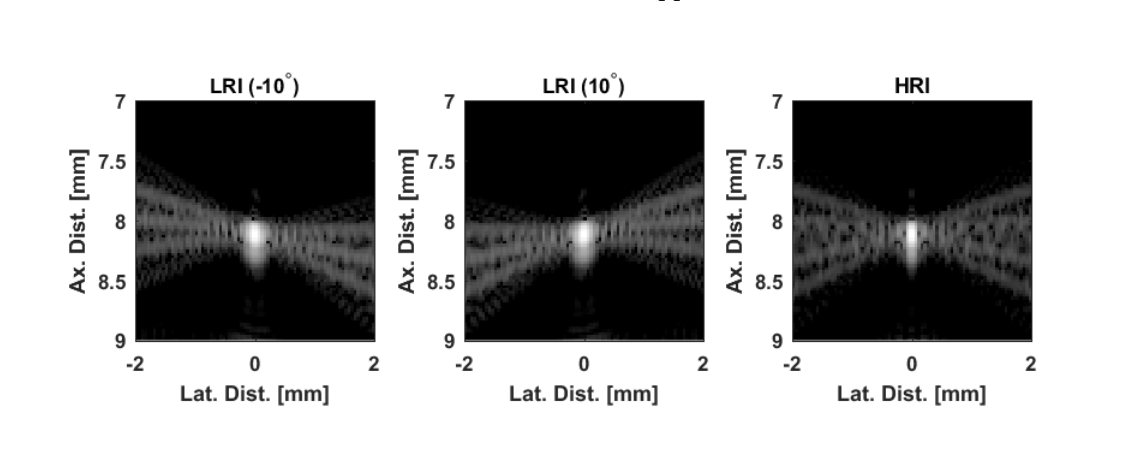
Figure 2. The coherent compounding approach generates high-resolution images (HRIs)by summing together low-resolution images (LRIs) formed at different steering angles. If we look at each LRI individually, we can see that the point spread function (PSF) rotates about the center as the steering angle changes. If we use the LRIs to produce Doppler estimates, the sidelobe rotation could be misinterpreted as tissue motion by the lag-one autocorrelation algorithm. Images are rendered at a 60-dB scale and are normalized to their corresponding